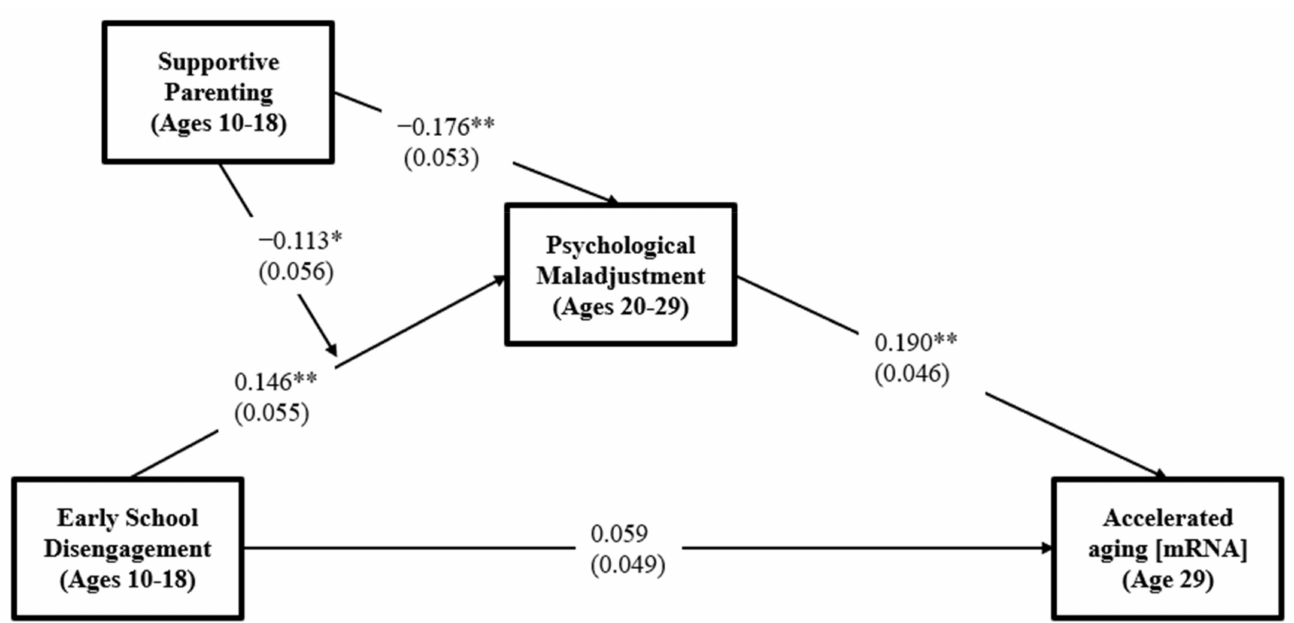
Figure 3. The conditional indirect effects of school disengagement and its interaction on accelerated aging at age 29 through psychological maladjustment moderated by supportive parenting. Chi- square = 5.881, df = 2, p = 0.0528; CFI = 0.952; SRMR = 0.023. Values are standardized parameter estimates, and standard errors are in parentheses. Gender, education, healthy diet, exercise, alcohol consumption, and smoking are controlled in these analyses. ** p ≤ 0.01, * p ≤ 0.05 (two-tailed tests), n =